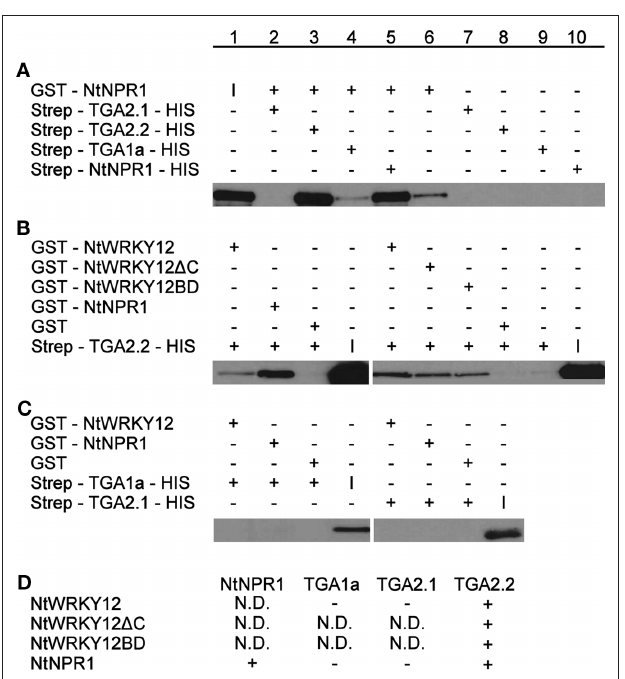
FiGuRe 3 | Pull-down assays of NtWRKY12, TGA1a, TGA2.1, TGA2.2, and NtNPR1. GST-proteins were incubated with Strep/HIS purified fusion proteins and complexes were pulled down with Streptactin–Sepharose beads (A) or Glutathione–Sepharose 4B beads (B,C) . After SDS-PAGE and Western blotting fusion proteins were detected with anti-GST antibodies (A) or anti-HIS antibodies (B,C) . Plus and minus signs denote the presence or absence in the incubation mixtures of the proteins indicated at the left. The input protein was loaded separately on gel and is indicated by (I). The table in (D) summarizes the results of the pull-down assays. Plus-sign, interaction, minus-sign, no interaction, N.D., not determined.